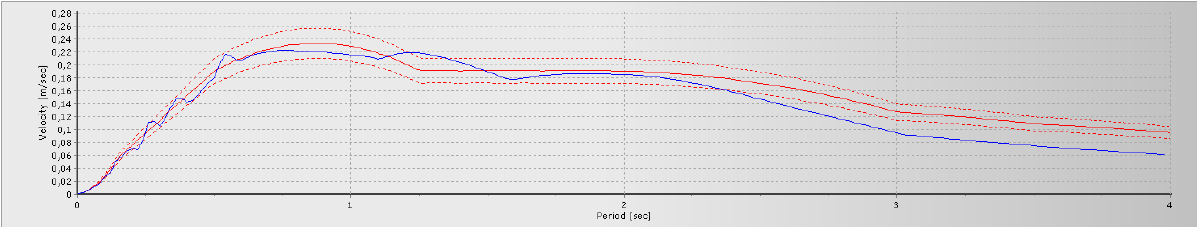
Figure 10. Comparison of the velocity.